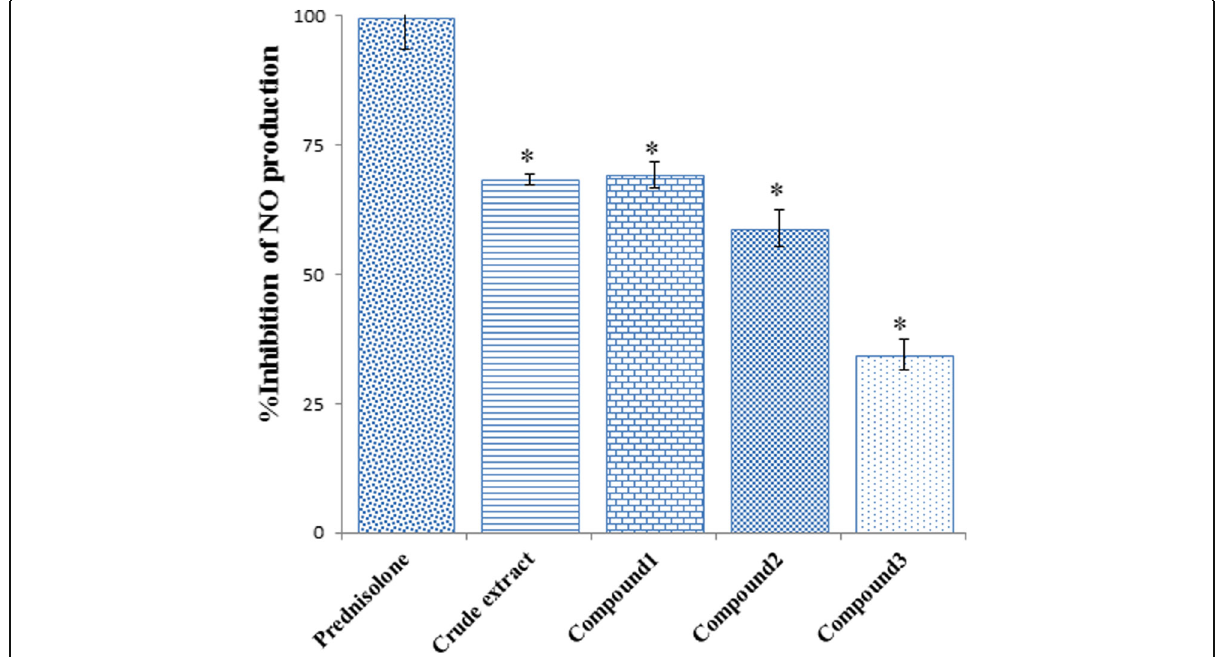
Fig. 3 Effect of ethanolic extract of B. montanum root and the isolated propiophenones at concentration of 50 μ g/mL on NO production from RAW 264.7 cells. Results are presented as mean±SD from triplicate experiment. Mean differences between sample and positive control were analyzed by student ’ s t-test. *Significant difference comparing tested sample and positive control analyzed by Student ’ s t-test ( p -value <